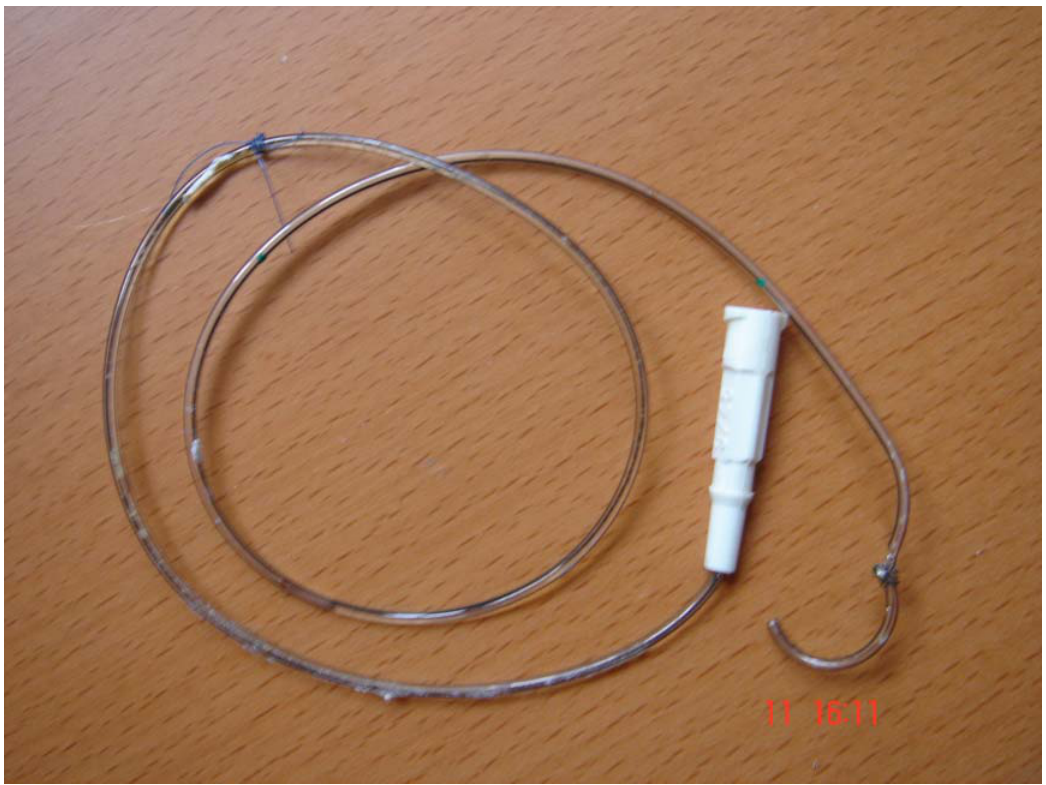
FIGURE 1. The SPC after removal, with the knot at the distal